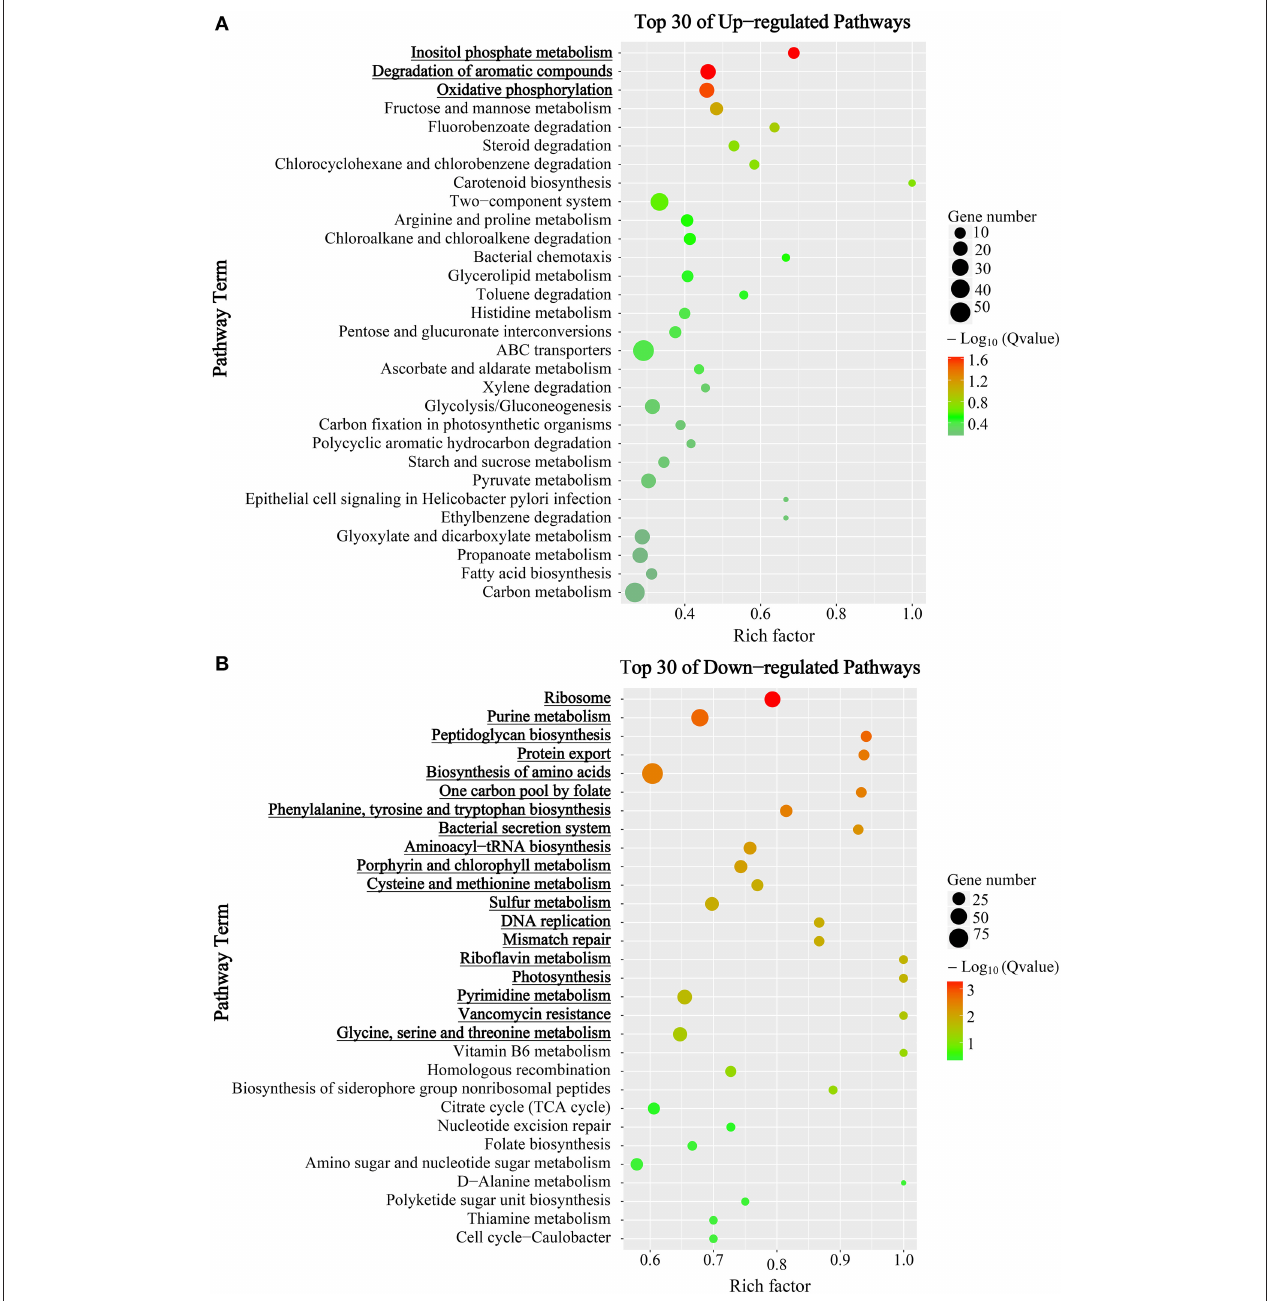
FIGURE 3 | KEGG enrichment analysis of DEGs between mid-exponential and mid-stationary phases. Y-axis label represents the distinct KEGG pathways, and X-axis label represents rich factor (rich factor = amount of DEGs in the pathway/amount of all genes in background gene set). The colors of the dots represent the Q-values of enrichment. Red color indicates high enrichment, while blue color indicates low enrichment. Pathway terms were sorted by Q-value in ascending order; and were marked in bold and underlined when Q-value < 0.05. The sizes of the dots represent the gene number of enrichment. (A) Top 30 up-regulated KEGG pathways. (B) Top 30 down-regulated KEGG